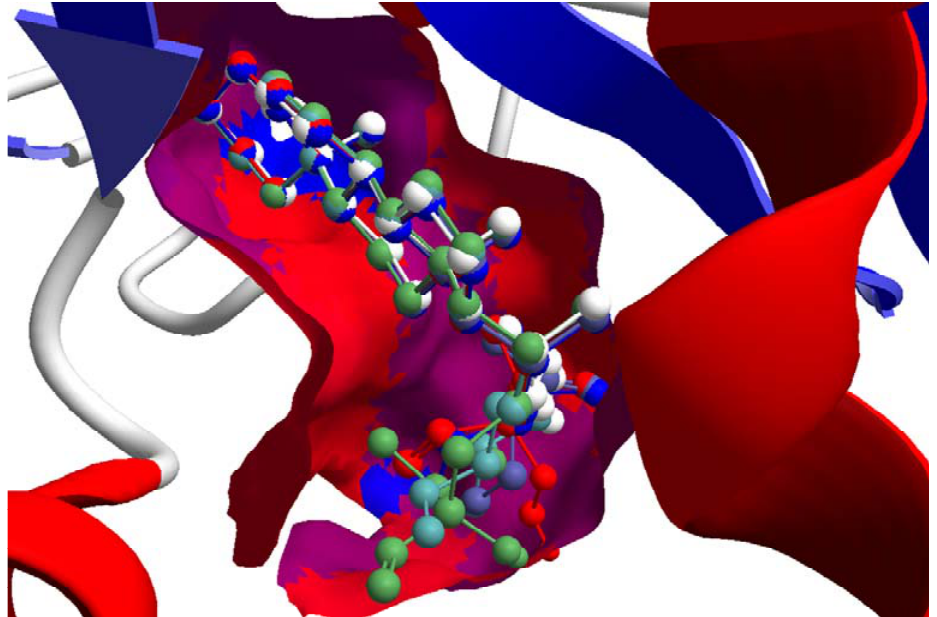
Figure 27. Lowest-energy poses of steroids, cholesterol (white), clerosterol (purple), saringosterol (green), stigmasterol (cyan),  -sitosterol (blue), and 24-hydroperoxy-24- vinylcholesterol (red), in the hydropobic pocket of L. major methionyl t-RNA synthetase (LmajMetRS, PDB